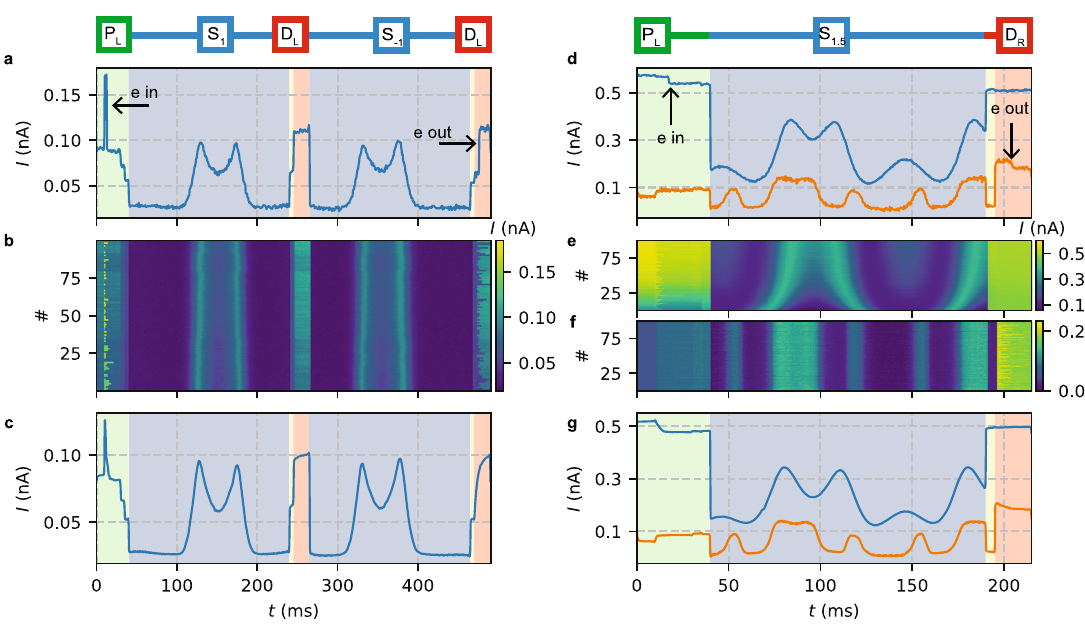
Fig. 2 Sensor signal traces for two shuttling pulse sequences. Firstly, a shuttling back and forth in the device is realized by loading an electron on the left, shuttling a distance of λ to the right, detecting on the left, shuttling a distance of λ to the left and detecting on the left ( a – c ). The second pulse sequence shuttling through the device consists of loading on the left, shuttling 1.5 λ to the right and detecting on the right ( d – g ). The pulse sequences are indicated above the panels. a Single trace of the sensor response for shuttling in and out on the left. The plot background color marks the duration of each pulse segment. b Left sensor signal of 100 shuttling traces. c Average sensor response of the 100 shuttling traces in b . d Single trace of left (blue) and right (orange) sensor response for shuttling through the device. e Left sensor signal of 100 shuttling traces. The current background change is due to automatic tuning of the sensor set point. f Right sensor signal of the same 100 shuttling traces. g Average sensor response of the 100 shuttling traces depicted in e , f . Both pulse sequences are applied with A S = 50 mV, B S = 730 mV and Δ B S = 100